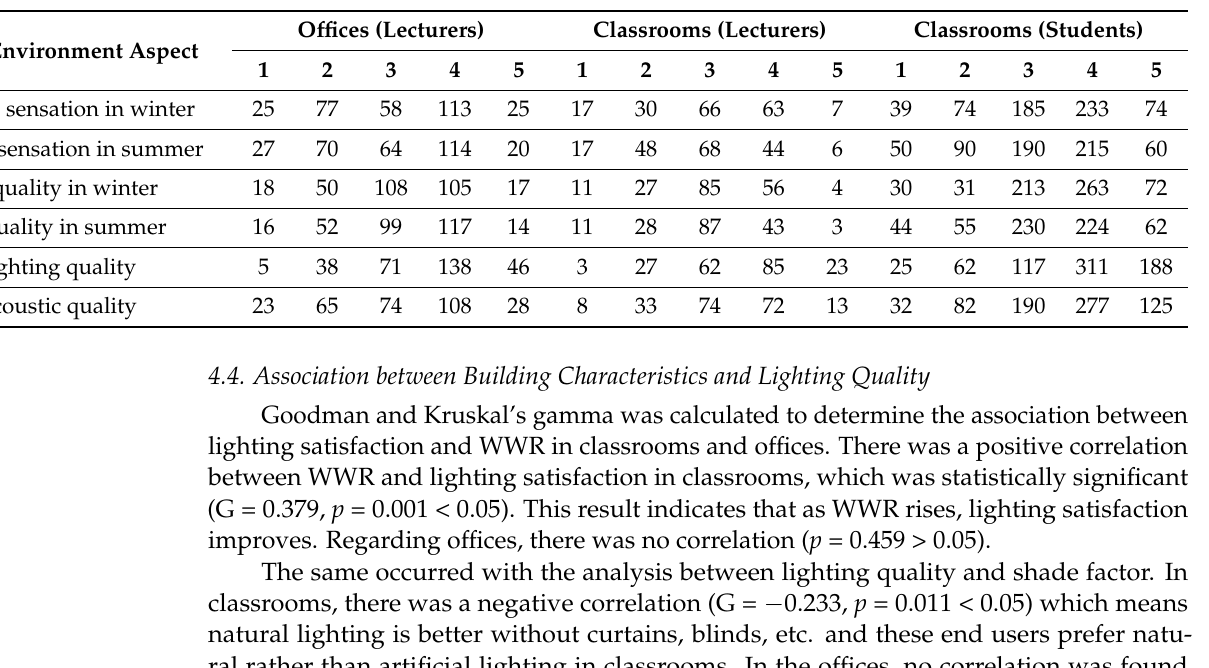
Table 4. Descriptive statistics of the survey